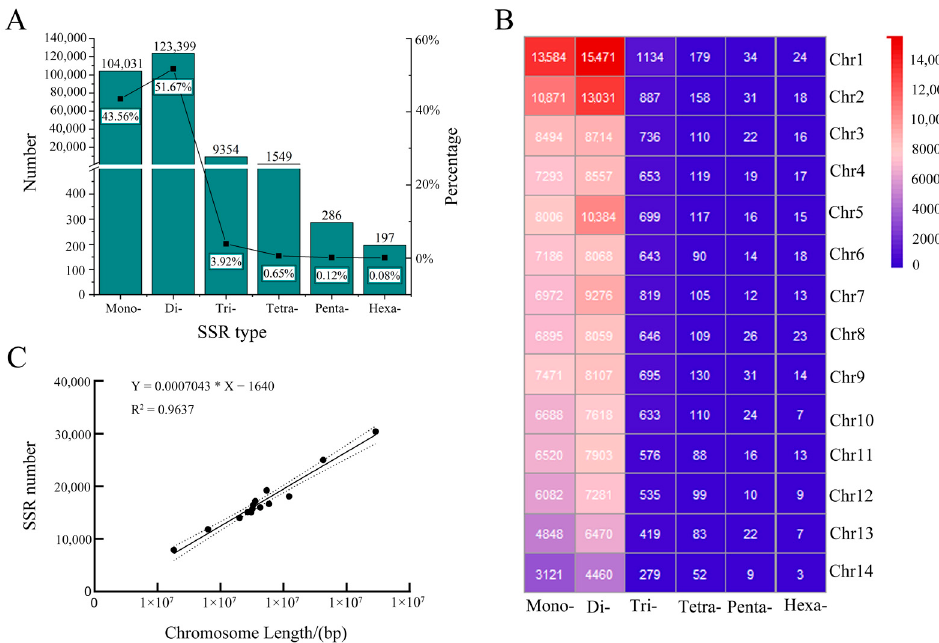
Figure 1. Number of SSRs identified on each chromosome in the N. colorata genome. Number and percentage of SSR markers ranging from mononucleotide to hexanucleotide repeats in the whole genome ( A ). SSR numbers ranging from mononucleotide to hexanucleotide repeats in each chromo- some ( B ). Pearson correlation analysis between SSR number and each chromosome length ( C ).